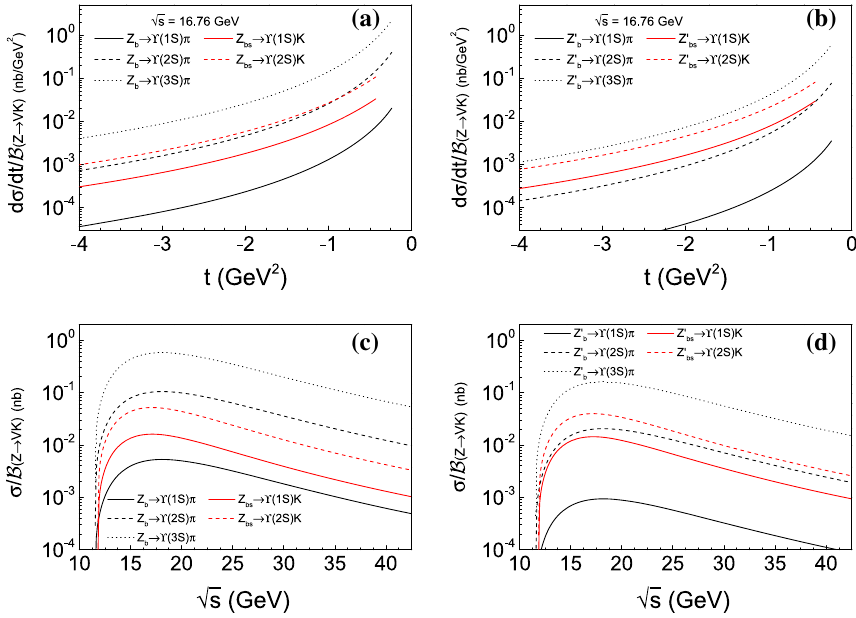
( (cid:3) ) are also shown for comparison bs